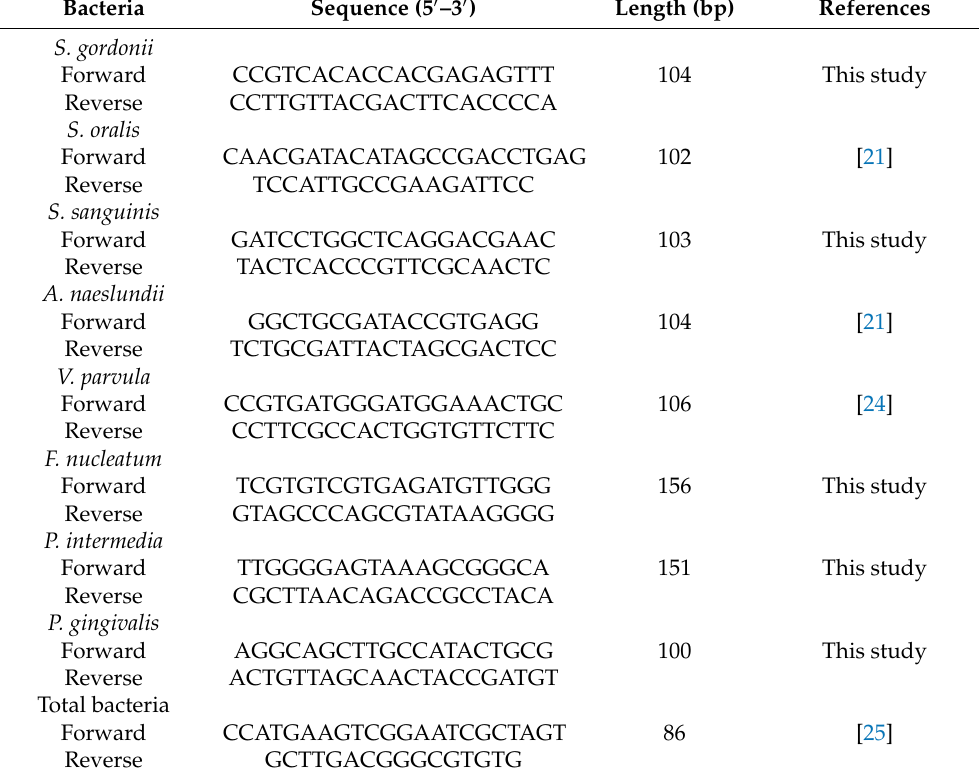
Table 1. Primer sequences used for the quantification of the target bacterial species in the biofilm.